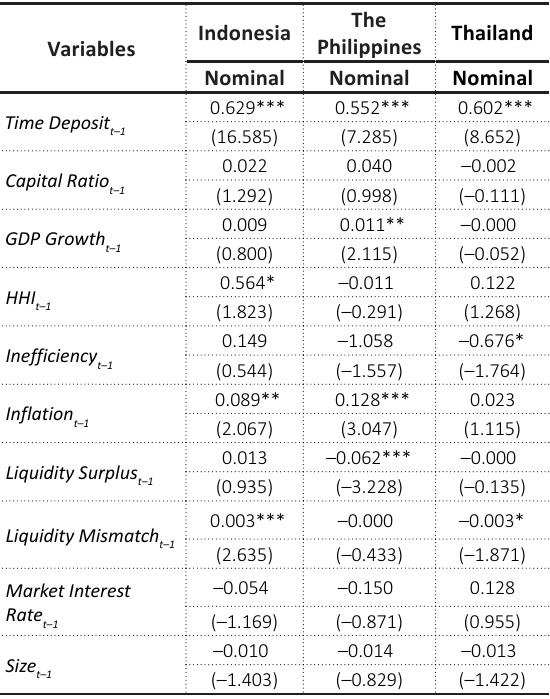
Table 4. Regression results of the Time Deposit